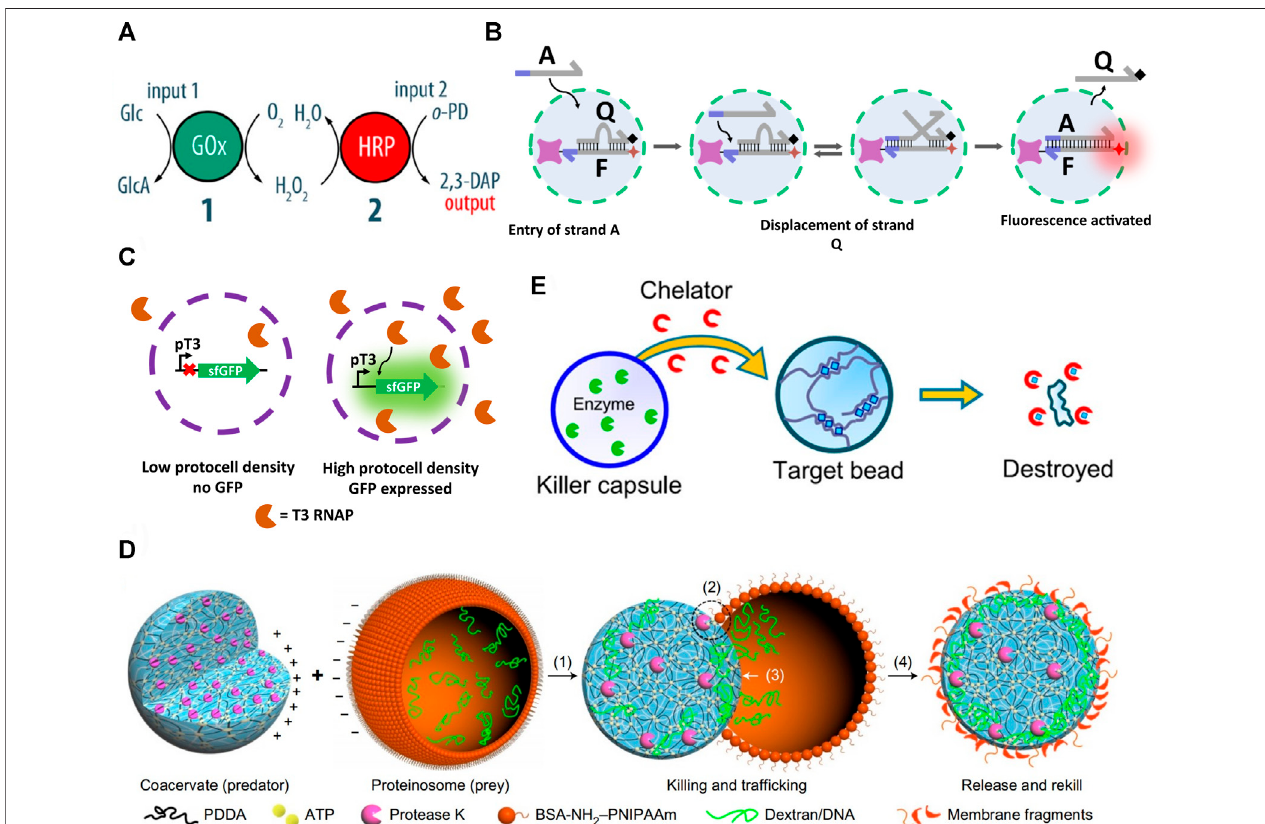
FIGURE1 | (A) Schematic describinga GOx/HRP enzyme cascade reaction between two populationsof coacervate microdroplets. In this system the input signal is represented by glucose (Glc), which gets oxidised to cluconolactone (GlcA) by the GOx-containing coacervate microdroplet. This reaction produces the signalling molecule H 2 O 2 , which diffuses radially from the GOx containing coacervate microdroplet and is utilised by the HRP-loaded coacervate microdroplet to oxidise o -PD to 2,3-DAP and produce a fl uorescent output signal (Tian et al., 2018). (B) Scheme describing the toehold DNA strand displacement communication mechanism betweentwoproteinosomes.TheinputchemicalsignalrepresentedbythesinglestrandedDNAstrand ‘ A ’ diffusesintoaproteinosome containingaDNAgate complex and displaces strand Q which is functionalised with a fl uorescence quenching moiety. The release of Q causes a fl uorescence turn-on of the fl uorophore which remains attached to the DNA gate complex inside the proteinosome (Joesaar et al., 2019). (C) Scheme describing quorum sensing in synthetic protocells. Polymer-based protocells contain plasmids coding for T3 RNA polymerase and for the green fl uorescent reporter protein (sfGFP). Only at high densities of protocells in dispersion the local concentration of T3 RNA polymerase is high enough to trigger the transcription of sfGFP (Niederholtmeyer et al., 2018). (D) Scheme describing the predatory behaviour of coacervate microdroplets towards proteinosomes. The coacervate “ predator ” contains sequestered protease K. Electrostatic interactions bring positively- charged coacervate into contact with negatively-charged proteinosome “ prey ” (1). Protease K digests the protein-polymer material that composes the proteinosome ’ s membrane and so breaks apart the proteinosome (2). The “ sponge-like ” nature of the coacervate allows it to take up the membrane components of the proteinosome (3,4) (Qiao et al., 2017). (E) Scheme showing the reactivity of “ killer ” chitosan polymersomes. The killer polymersomes were loaded with GOx (green shapes) which converted glucose to gluconate “ chelator ” (red shapes). Gluconate diffused to the Cu 2+ -crosslinked “ target ” polymersomes and sequestered the copper ions (blue squares), causing the death of the target protocell (Arya et al., 2016). All fi gures adapted with